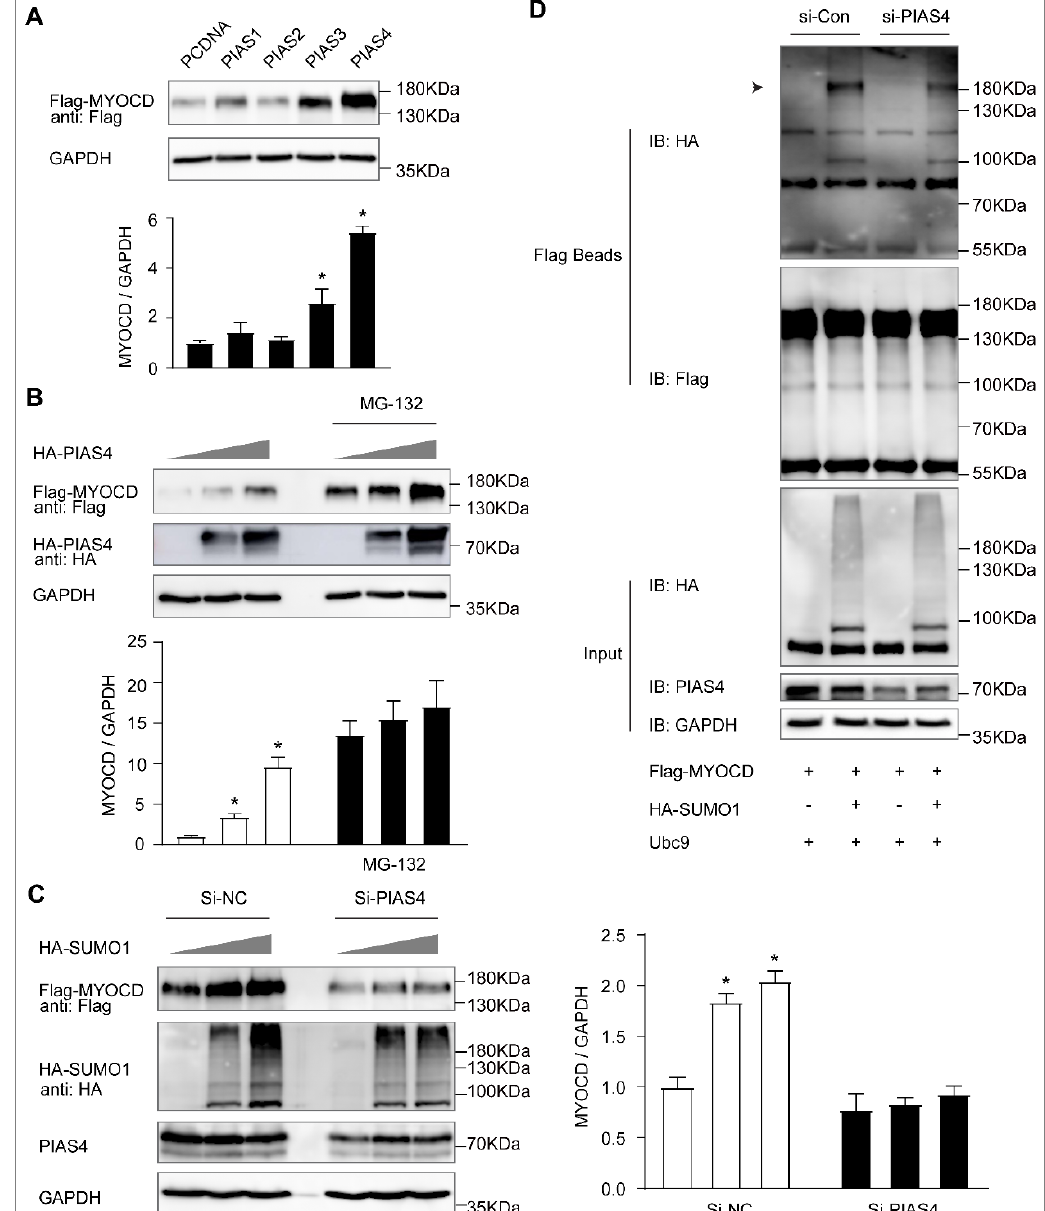
Figure 5. PIAS4 is the SUMO E3 ligase that mediates myocardin SUMOylation. ( A ) HEK-293T cells were transfected with Flag-MYOCD and HA-PIAS1, HA-PIAS2, HA-PIAS3, or HA-PIAS4 for 24 h. Lysates were prepared and analyzed by Western blotting (n = 3, * p < 0.05). ( B ) HEK-293T cells were transfected with Flag-MYOCD and increasing amounts of HA-PIAS4 for 24 h, in the presence or absence of MG132 (10 µ M) for the last 10 h. Lysates were prepared and analyzed by Western blotting. ( C ) HEK-293T cells were transfected with control siRNA (si-NC) and PIAS4 siRNA (si-PIAS4) for 48 h and then transfected with increasing amounts of HA-SUMO1 for another 24 h. Lysates were prepared and analyzed by Western blotting (n = 3, * p < 0.05). ( D ) HEK-293T cells were transfected with control siRNA (si-NC) and PIAS4 siRNA (si-PIAS4) for 48 h and then transfected with or without HA-SUMO1 for another 24 h. The SUMOylation of Flag-MYOCD was determined by the IP assay using Flag beads and Western blotting using anti-Flag, anti-HA, anti-PIAS4, and anti-GAPDH antibodies (n = 3, * p <